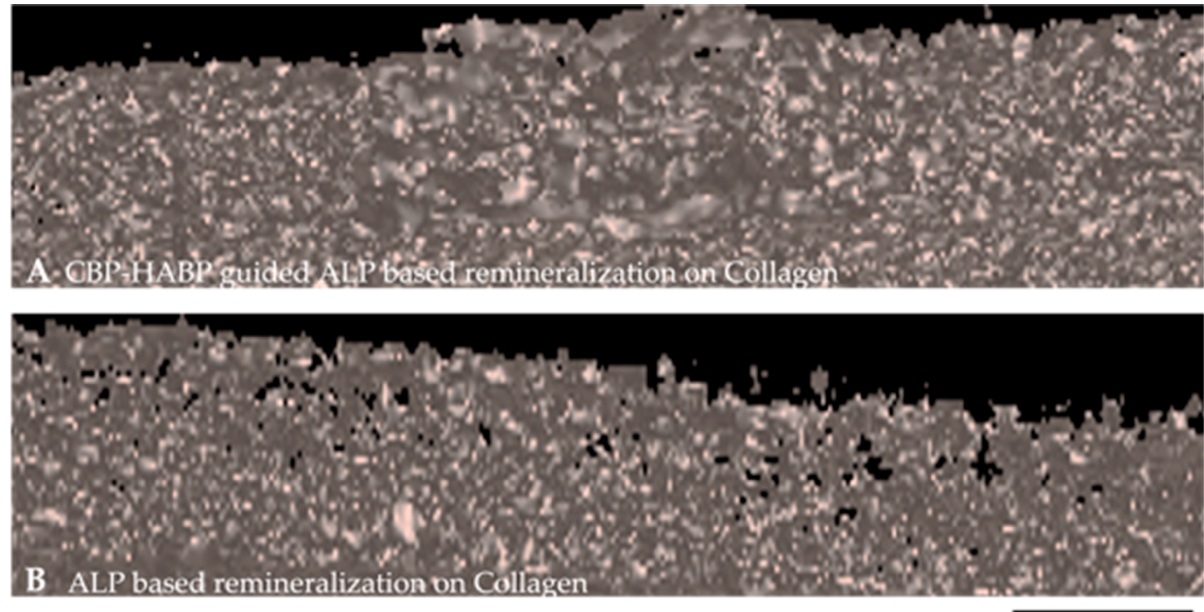
Figure 12. Shaded surface display of mineral formation on peptide-functionalized collagen samples, via Micro-CT, after 20-min ALP-driven mineralization, magnification level 20×. ( A ) CBP-HABP guided ALP-based mineralized collagen samples. ( B ) ALP-based remineralization on collagen samples. Scale bar is under each image, 50 μ m.